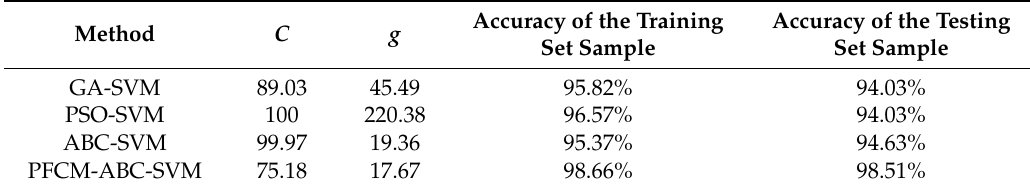
Table 6. The comparison between the PFCM-ABC-SVM method and the other methods.